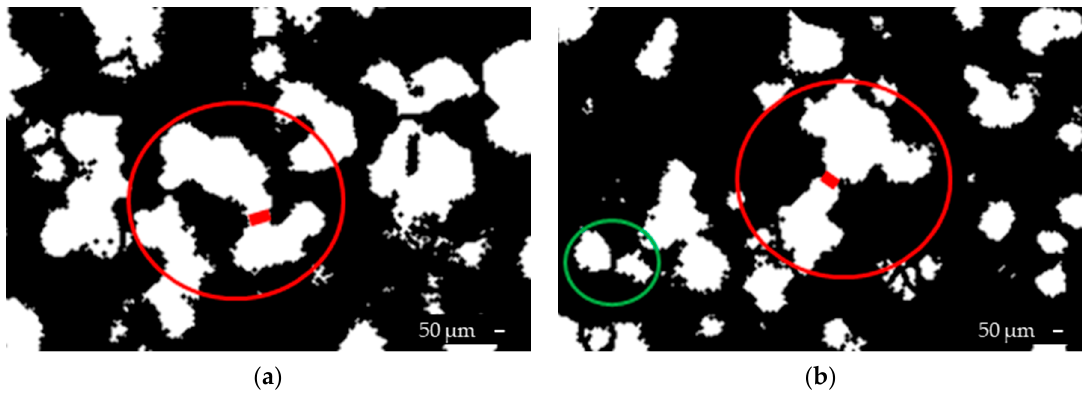
Figure 6. The images after the proposed segmentation with merged grains ( a ) and with both, correctly separated (green circle) and not (red circle) grains ( b ).